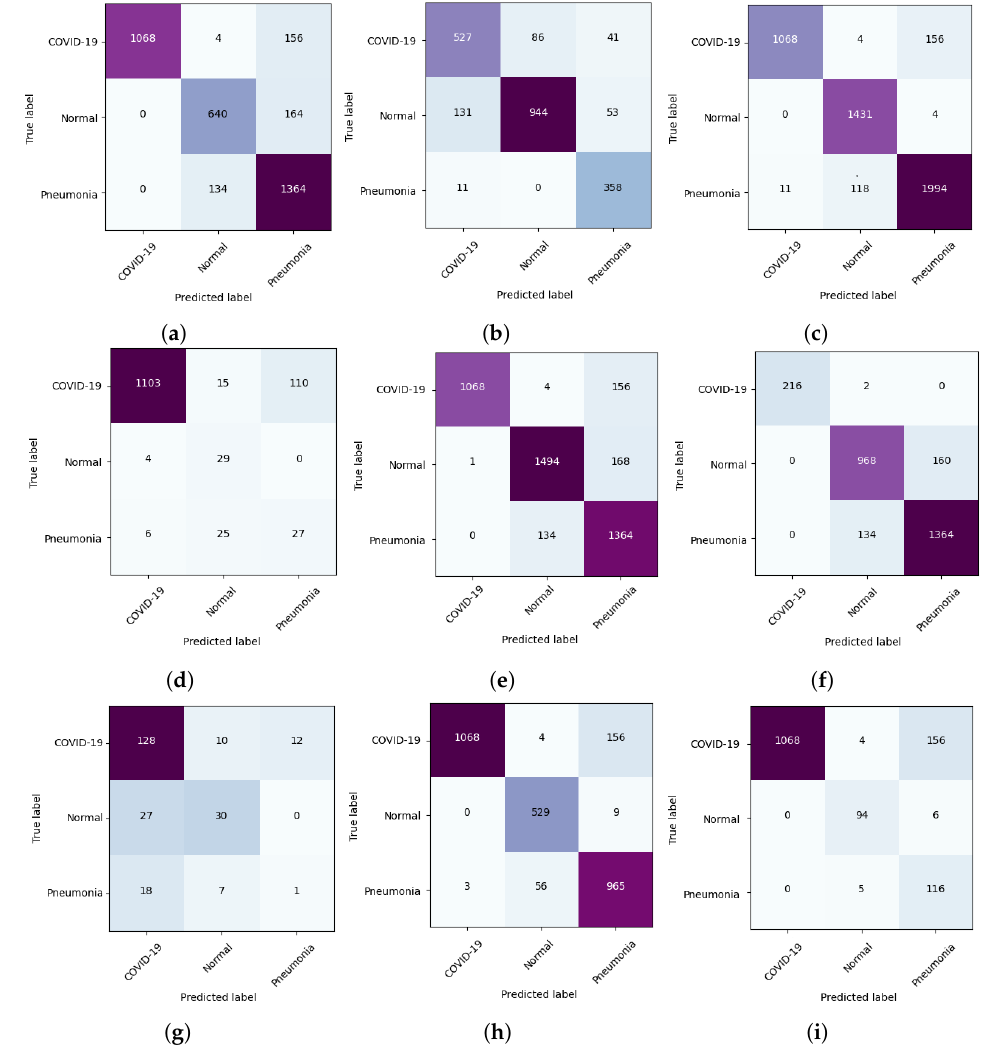
Figure 24. Confusion matrices of DeepCCXR-Multi (COVID-19 vs. pneumonia vs. normal): ( a ) BIMCV COVID19+; ( b ) CIDC; ( c ) CXRIP; ( d ) MONTGOMERY; ( e ) NIH; ( f ) COVID-19 RADIOGRA- PHY; ( g ) Montfort; ( h ) RSNA; ( i )